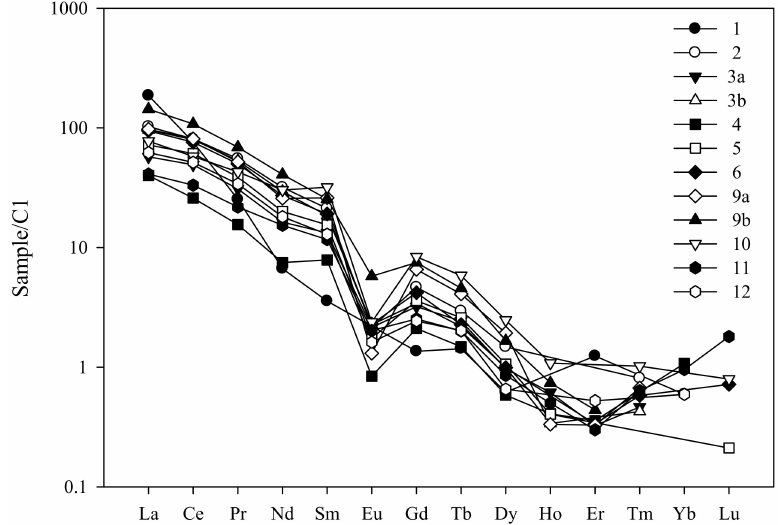
Figure 11. REE patterns normalized to the C1 values reported in [27] for all the analysed